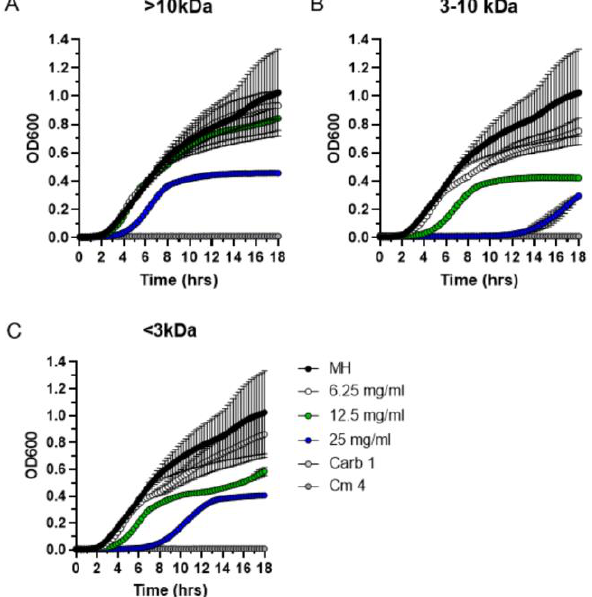
Figure 7. Size fractionation of P. patens exudate. Exudate from four-week-old P. patens Gd culture was fractionated into three molecular weight fractions, >10 kDa ( A ), 3–10 kDa ( B ), <3 kDa ( C ). Each exudate fraction was analyzed by MIC assay at three different concentrations (6.25, 12.5 and 25 mg/mL). MH— S. aureus growth in liquid MH medium without exudate addition. Carbenicillin (Carb, 1 µg/mL) and chloramphenicol (Cm, 4 µg/mL) were used as positive controls.